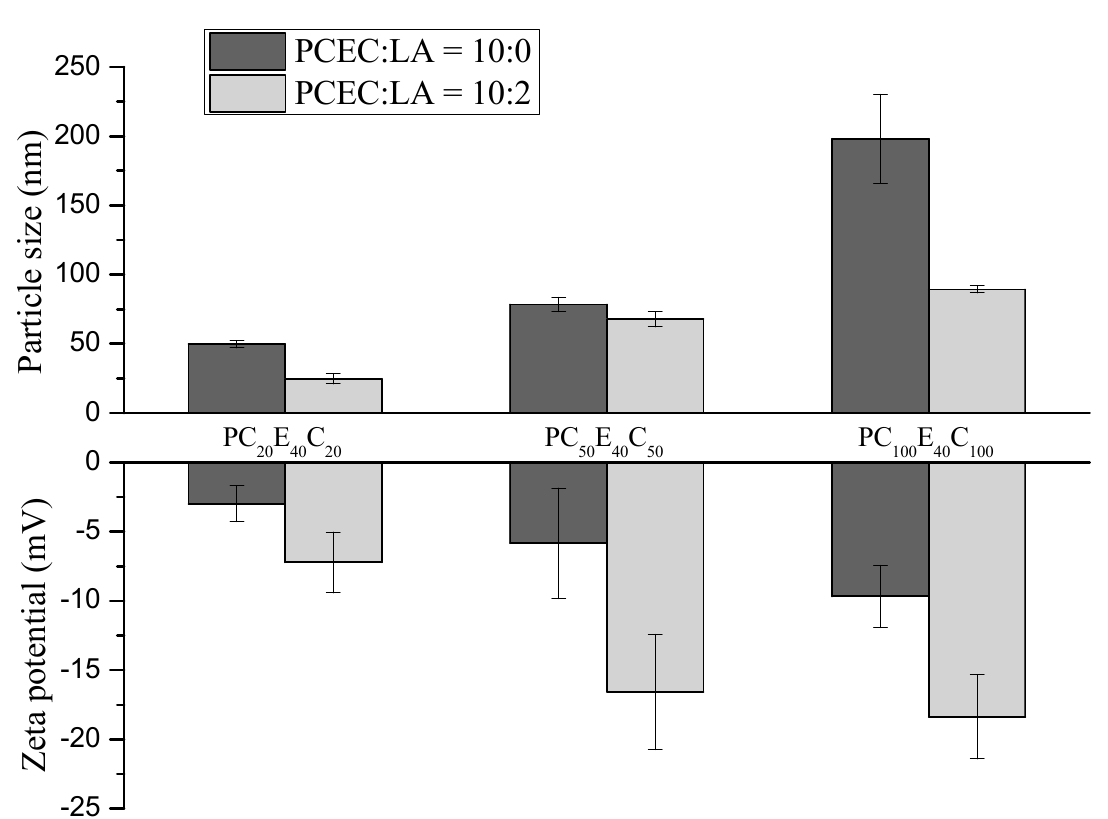
Figure 4. The average particle size and zeta potential of the micelles.